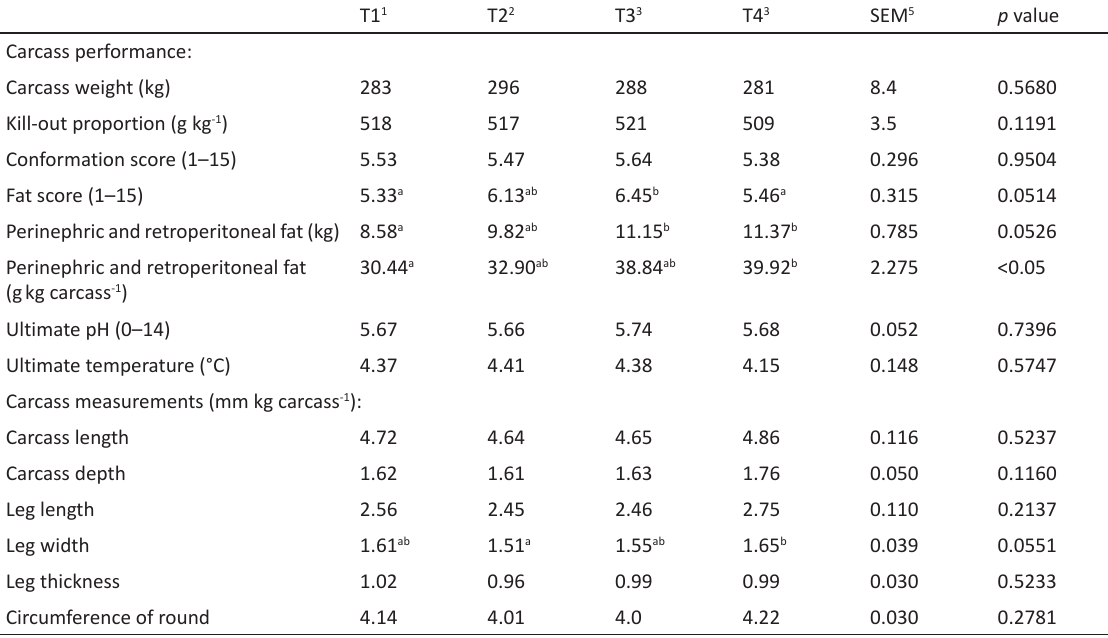
When expressed as a proportion of carcass weight perinephric and retroperitoneal fat was greatest for T4 and lowest for T1 with both T2 and T3 intermediate ( p <0.05). Ultimate pH and temperature were similar across all treatment groups. Table 4. Effects of finishing regime on ultrasound measurements, animal and carcass measurements and ultimate pH and ultimate temperature of Holstein-Friesian bulls slaughtered at 15 months of age T1 1 T2 2